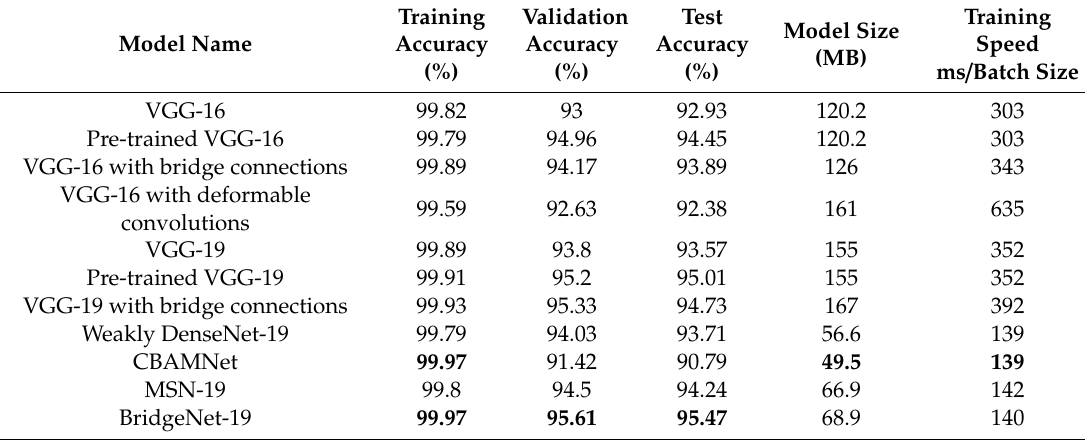
Table 5. Comparison of model